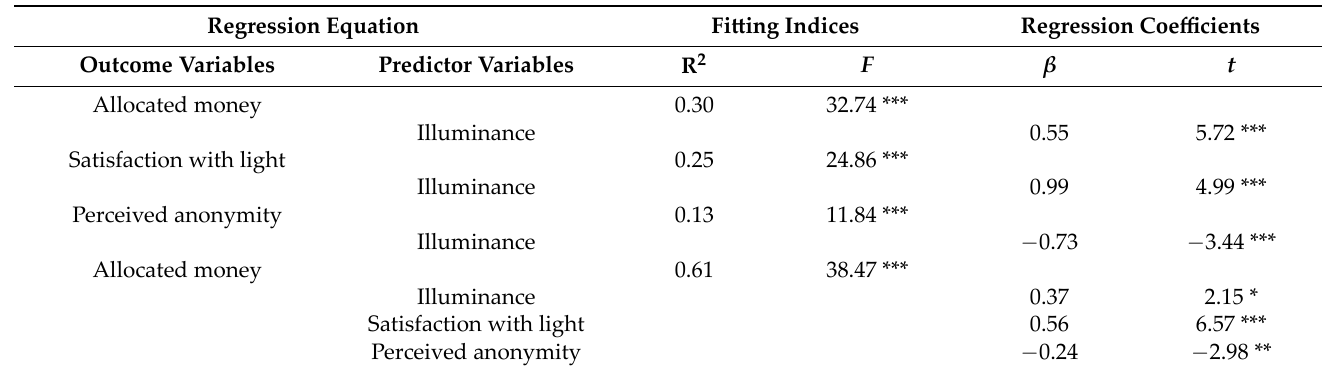
Table 5. Results of regression analyses.